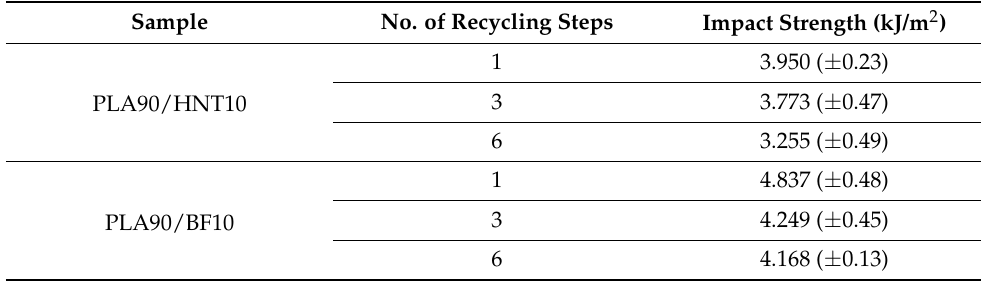
Table 5. Impact strength results of tested samples ( n =